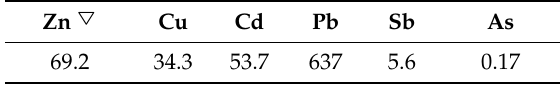
Table 3. Zinc and main impurity content in lixivium (mg/L).